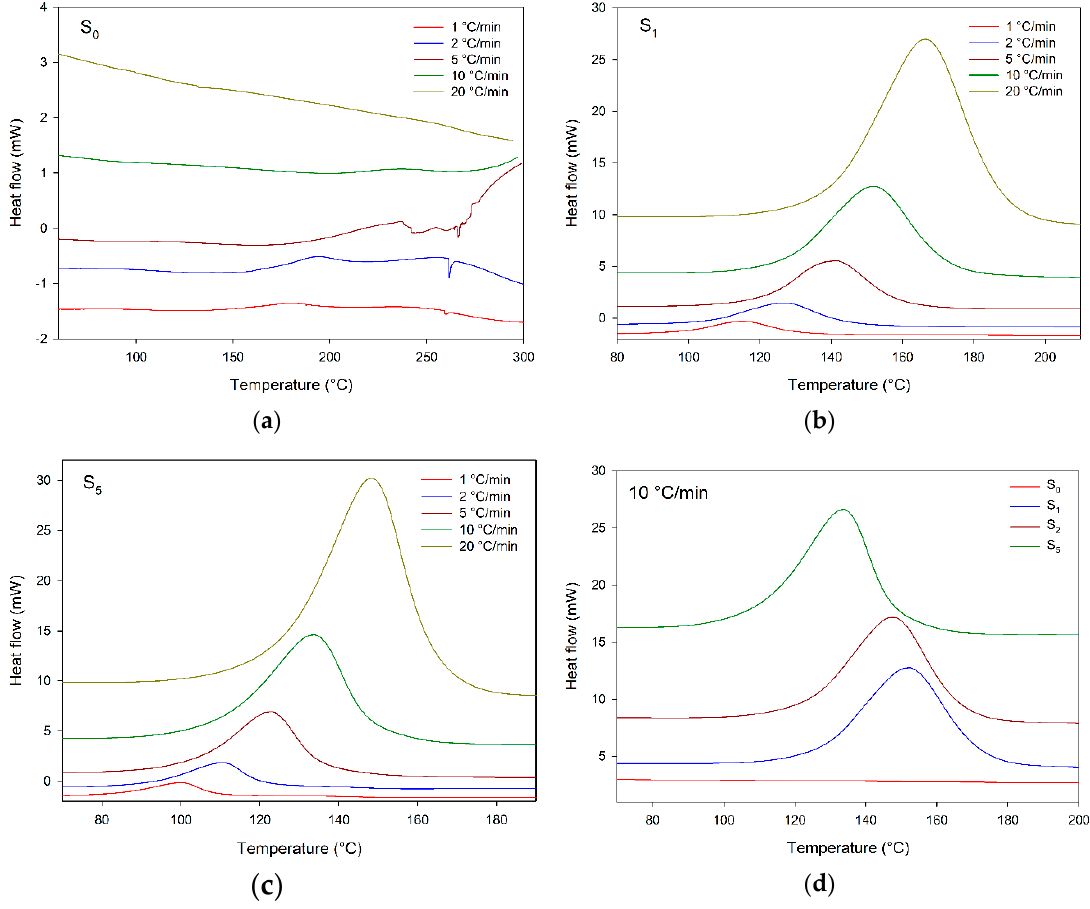
Figure 3. DSC scans of S X benchmark compounds ( a ) S 1 , ( b ) S 2 , ( c ) S 5 , and ( d ) S 0 , S 1 , S 2 , and S 5 computed at 10 ◦ C /